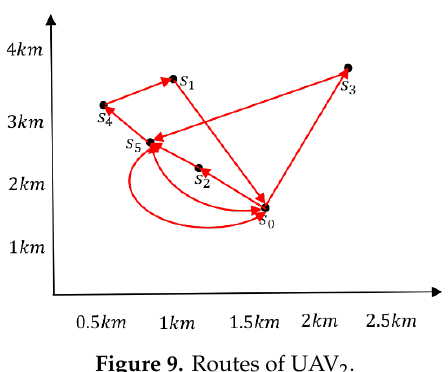
Figure 9. Routes of UAV 2 .